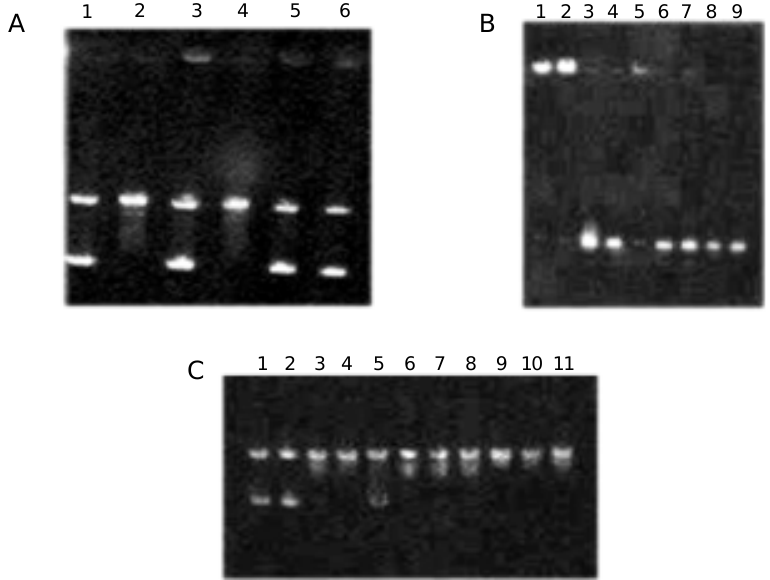
Figure 1. Agarose gel electrophoresis showing the effect of drugs on the relaxation of supercoiled DNA by topoisomerase I, and on decatenation of kDNA and relaxation of supercoiled DNA by topoisomerase II- α . A , 0.125 µg pBR322 DNA alone (lane 1) was incubated with topoisomerase I (4 U) (lane 2) in the presence of 200 µM biflavonoid I (lane 3), 200 µM rutin (lane 4), 200 µM biflavonoid II (lane 5), and 50 µM campothecin (lane 6). B , kDNA alone (lane 1), kDNA + topoisomerase II- α (2 U) + 100 µM etopo- side (lane 2), and kDNA + topoisomerase II- α (2 U) (lane 3), in the presence of 50 µM biflavonoid I (lane 4), 200 µM biflavonoid I (lane 5), 50 µM biflavonoid II (lane 6) and 200 µM biflavonoid II (lane 7), 50 µM biflavonoid IIa (lane 8) and 200 µM biflavonoid IIa (lane 9). C , pBR322 DNA alone (lane 1) was incu- bated with topoisomerase II- α (4 U) (lane 3) in the presence of 100 µM etoposide (lane 2), 50 µM biflavonoid I (lane 4) and 200 µM biflavonoid I (lane 5), 10, 50 and 200 µM biflavonoid II (lanes 6, 7 and 8, respectively), and 10, 50 and 200 µM biflavonoid IIa (lanes 9, 10 and 11,